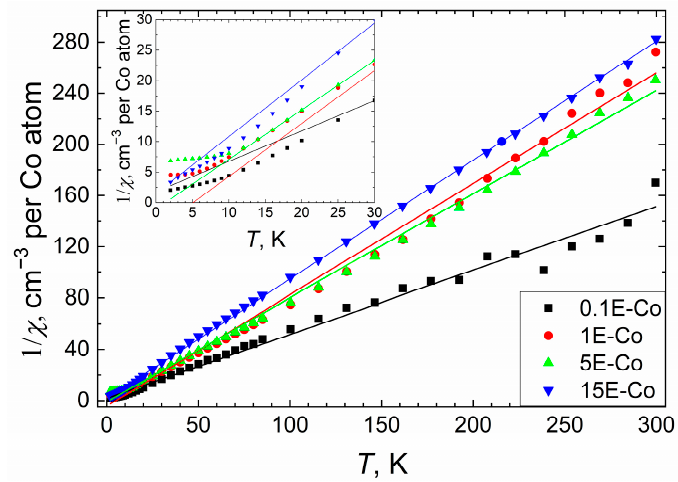
Figure 10. Temperature dependence of the inverse magnetic susceptibility as collected in an applied DC magnetic field of 0.5 T for aerogels with different EDTMS content (data calculated per Co atom, according to EDX results). Insert: low temperature range.